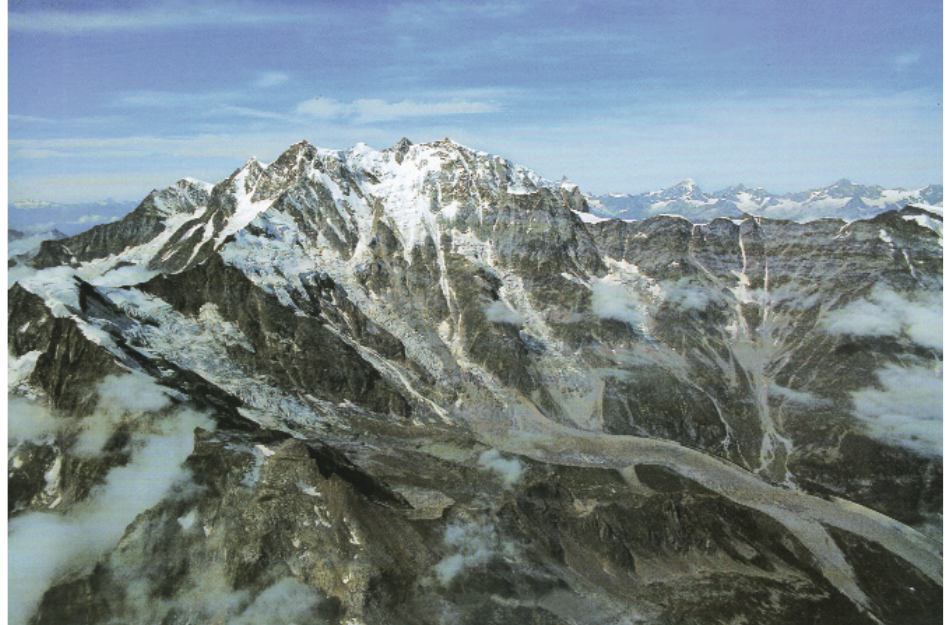
Figure 3. The Belvedere Glacier (photo: